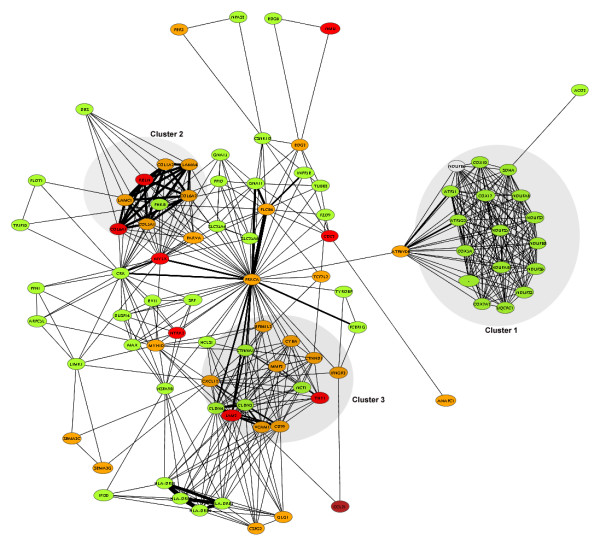
Genes and gene pathways affected by Hsa21 trisomy. Pathway analysis was performed with Pathway Miner software on the 473 genes dysregulated in trisomic samples. The most affected pathways are: Oxidative Phosphorylation (cluster 1), containing 16 genes downregulated in trisomic samples, and Focal Adhesion (cluster 2), containing at least 7 genes upregulated in trisomic samples. Cluster 3 is a network of Cell Adhesion genes, mostly upregulated in trisomic samples. Downregulated genes in cluster 1 are all mitochondrial genes; upregulated genes in clusters 2 and 3 are mostly ECM genes. Green indicates downregulated genes (darker green = more downregulated); red indicates upregulated genes (darker red = more upregulated).